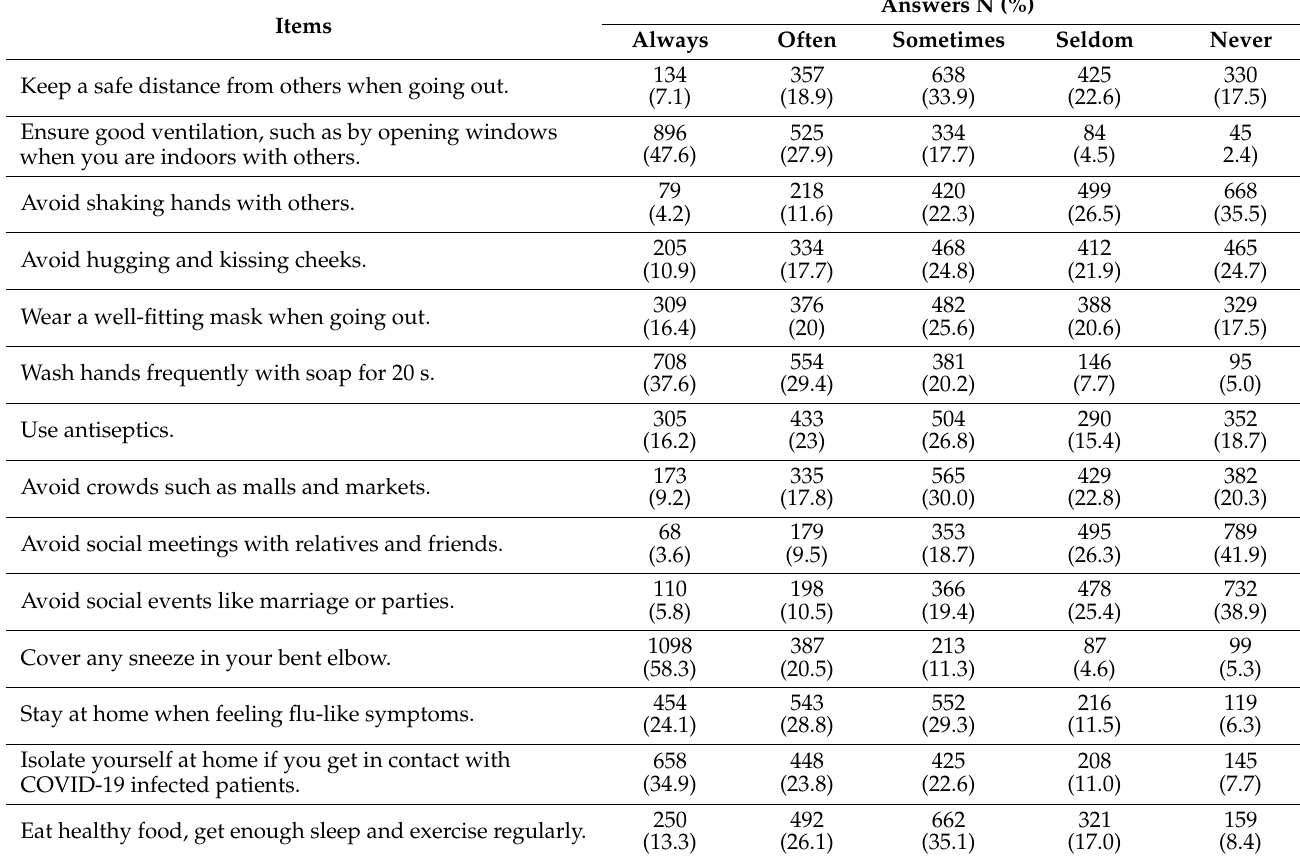
Table 3. Status of protective behavior following